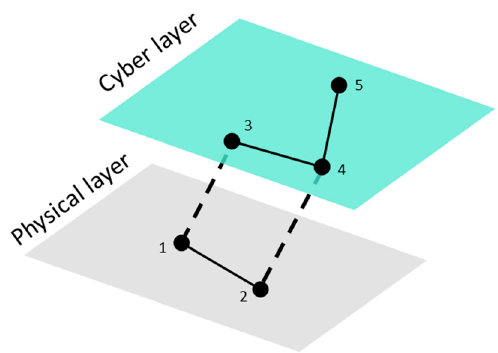
Figure 1. An example of a basic OT-IT multilayer system.